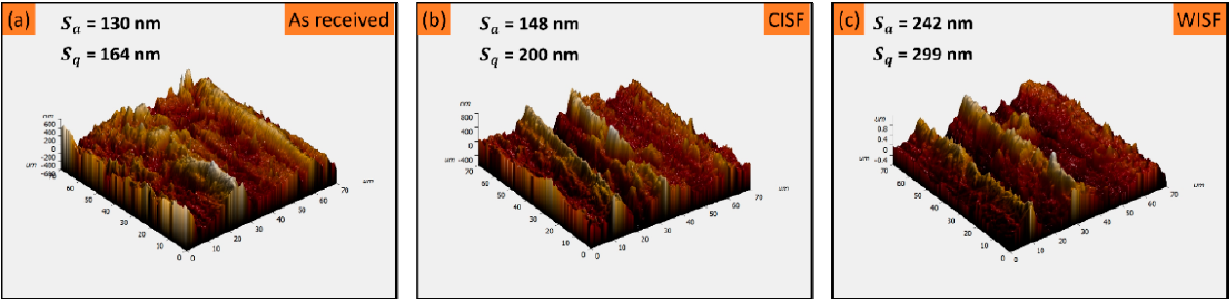
Figure 18. AFM surface profile of the sheet: ( a ) undeformed, ( b ) cone formed by CISF, and ( c ) cone formed by WISF.